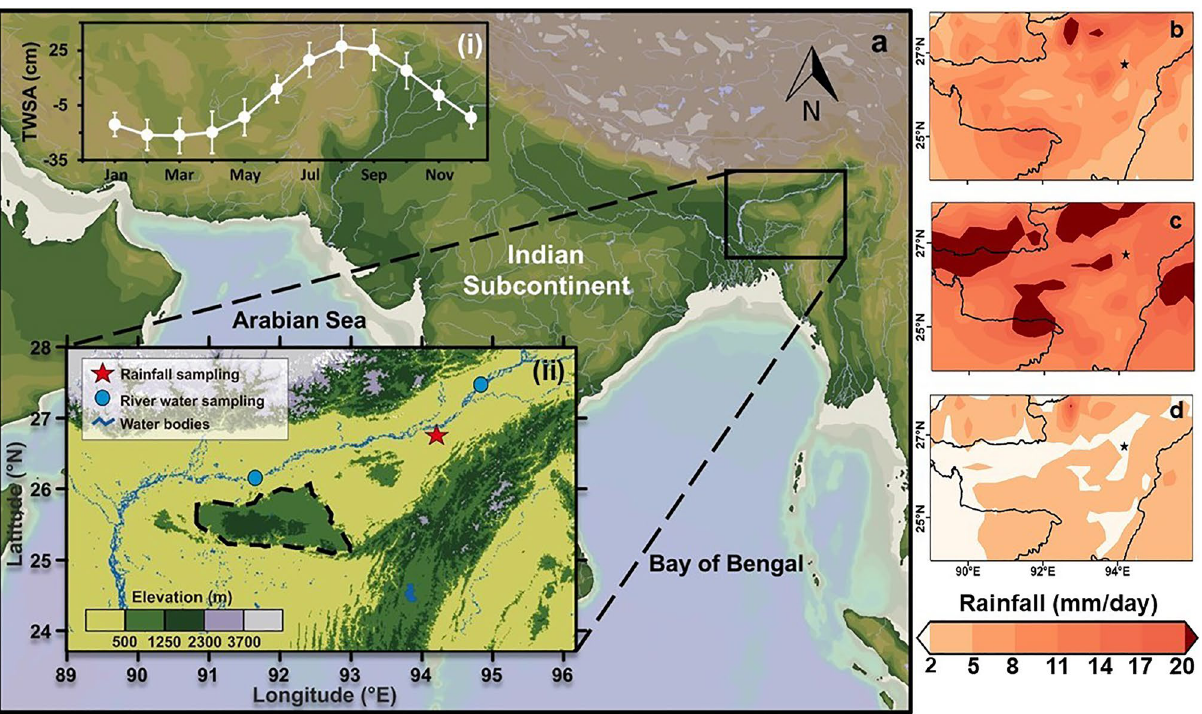
Figure 1. Study Area. ( a(i) ) GRACE TWSA seasonal variation during 2008–2013 indicating surface moisture availability in the region. The error bars represent standard deviation. ( a(ii) ) Map of North-East India depicting the study region. Jorhat, our precipitation sampling station is marked on the map (red star), along with location of major river sampling locations (blue circle). ( b – d ) The monthly climatology of rainfall amount for the